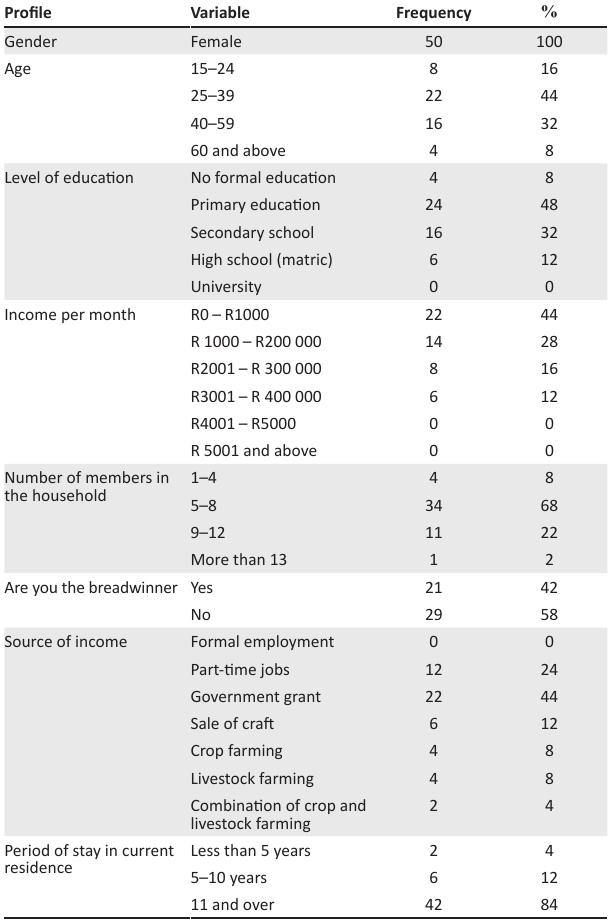
TABLE 1: Demographic characteristics of respondents ( n =